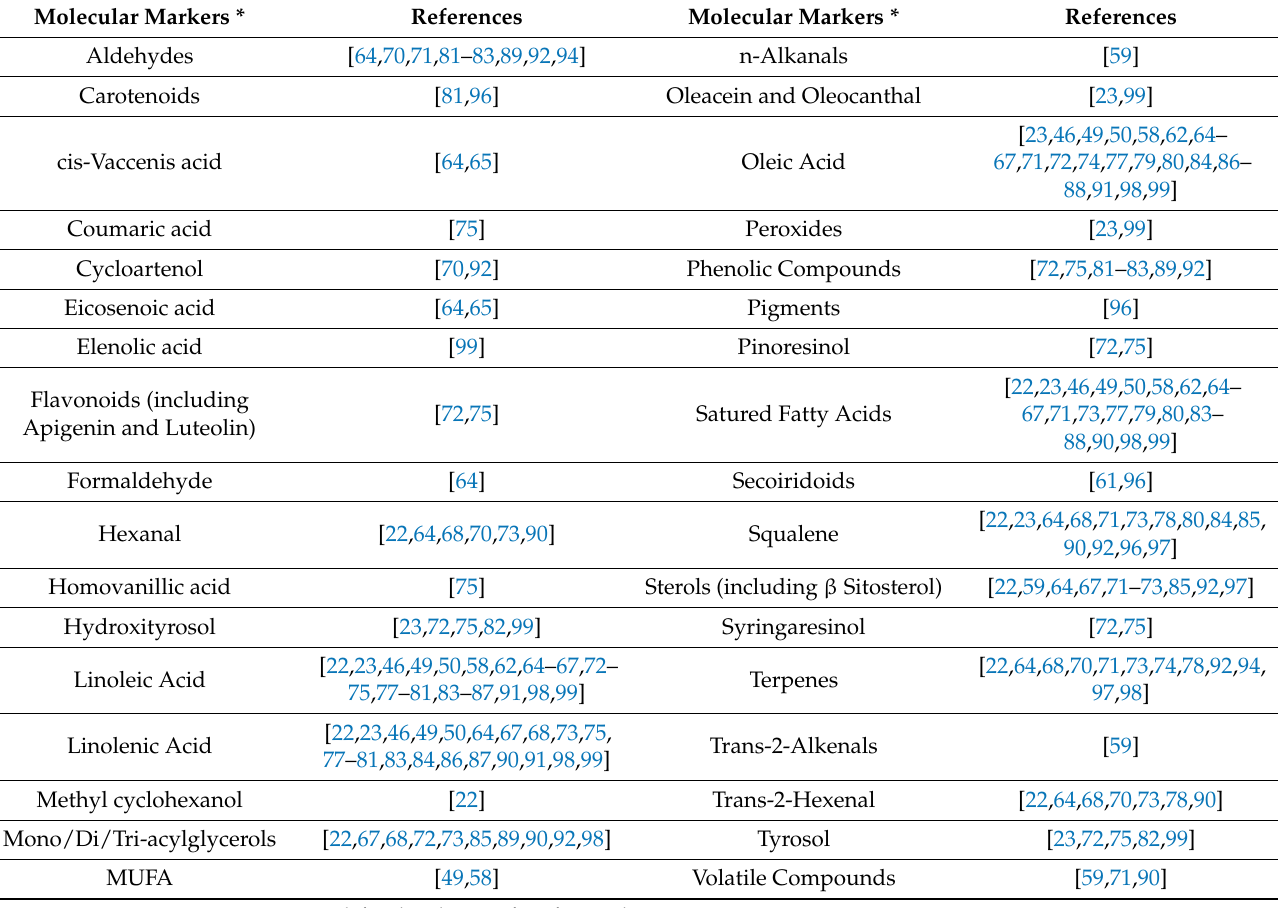
Table 3. Key molecular markers identified in NMR studies of Table 2.